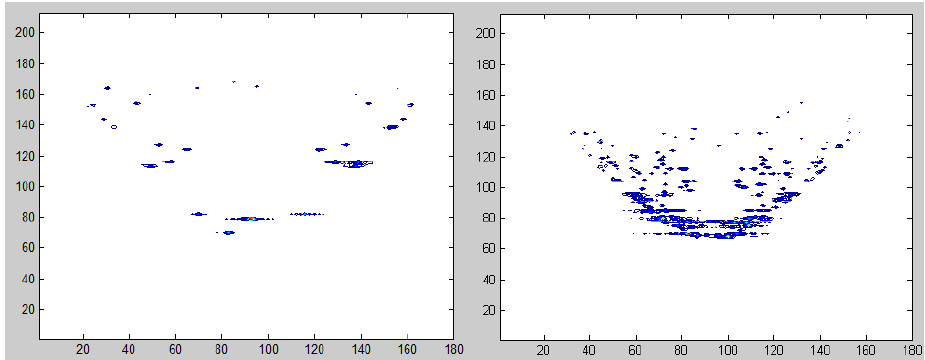
Fig. 5. Comparative images for pulse radiation with a different number of simulated reflectors: 50 on the left and 500 on the right; other conditions are the same: height is 200 m, horizontal speed is 100